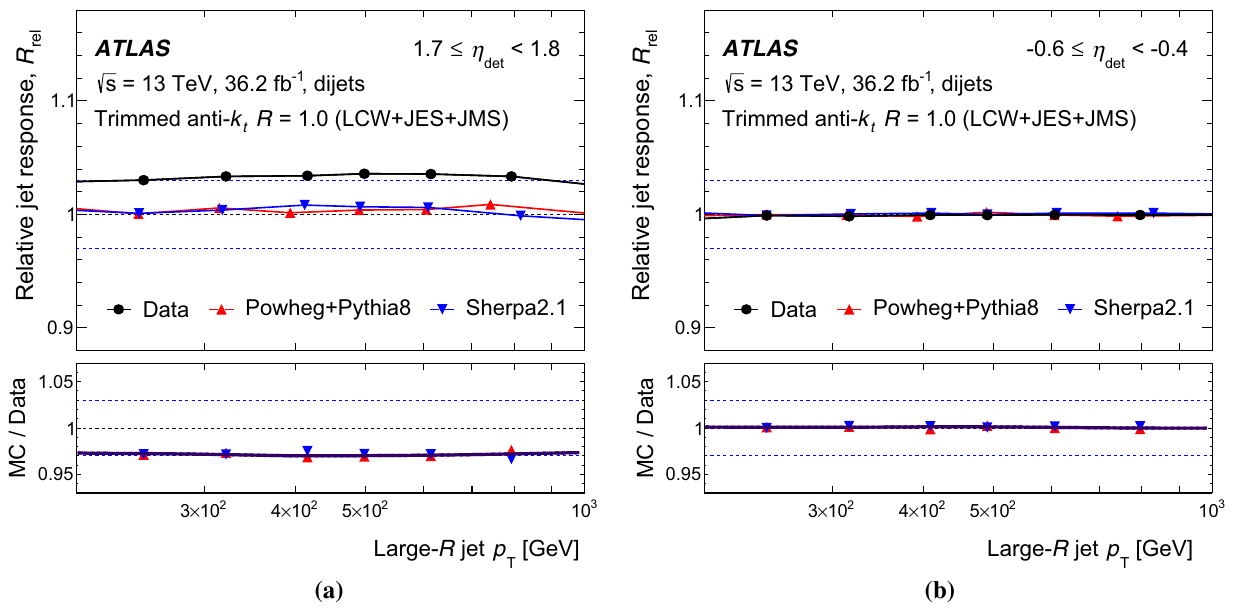
b − 0 . 6 < η det < − 0 . 4. In the lower panels, the lines interpolating between Powheg + Pythia markers are obtained by smoothing with a filter using a sliding Gaussian kernel